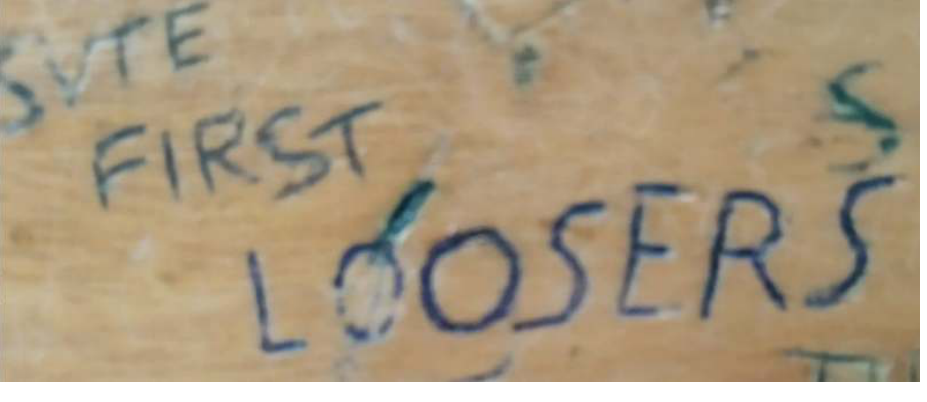
SVTE FIRST LOOSERS Photo: J.